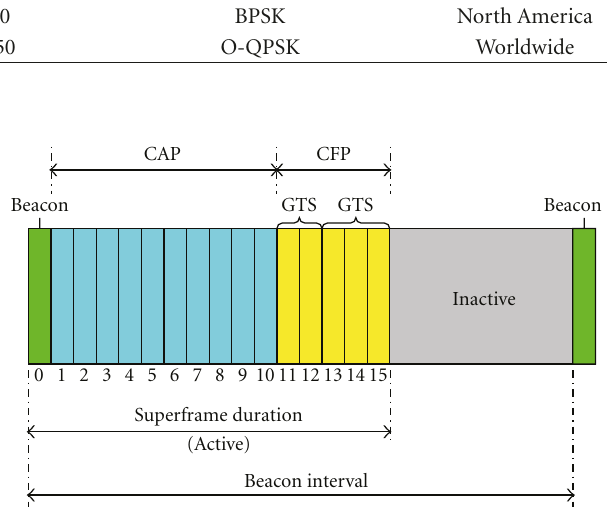
Figure 1: Superframe